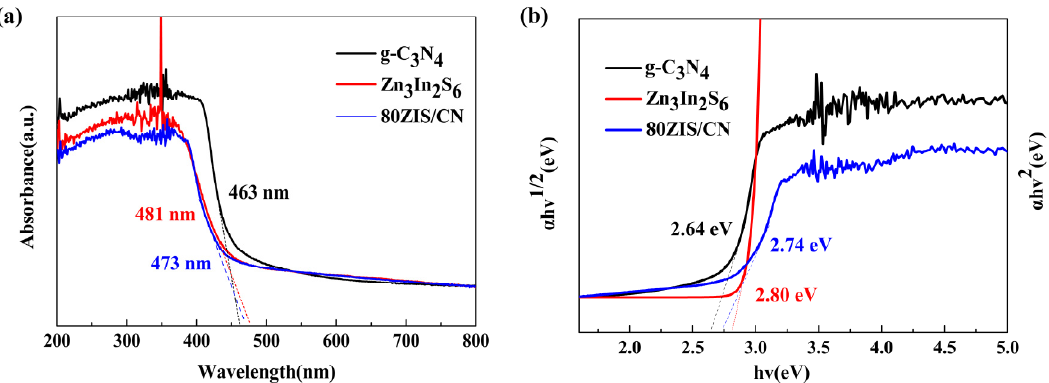
Figure 3. ( a ) UV–vis spectra ( b ) the plots of ( ahv ) n /2 vs. hv : g-C 3 N 4 nanosheets, Zn 3 In 2 S 6 and binary 80ZIS/CN.